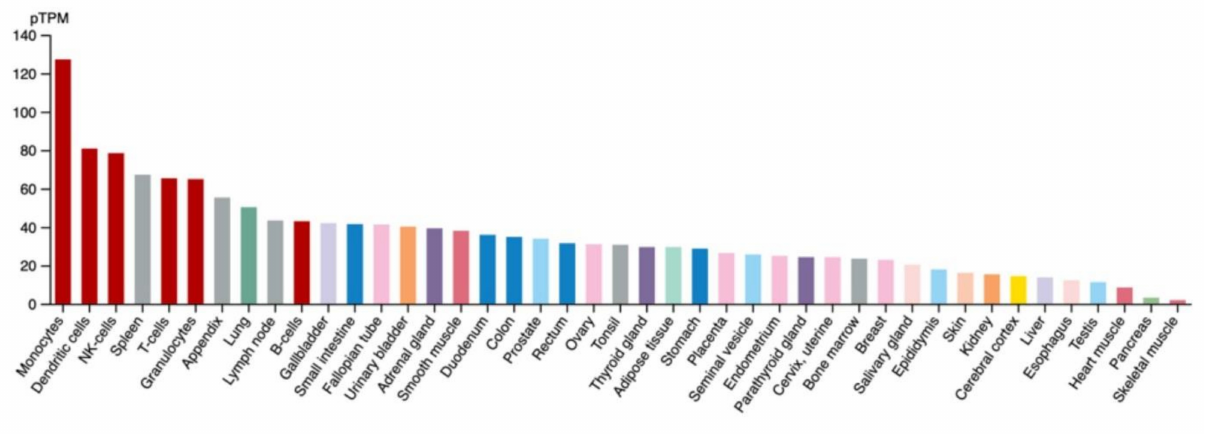
Figure 2. The human protein atlas. Note the preponderant expression of IFP35 in the tissue and cells of the immune system. The pTPM protein-transcripts per million. (Figure reproduced from https://www.proteinatlas.org/ENSG00000068079-IFI3 5/tissue, accessed on 7 September